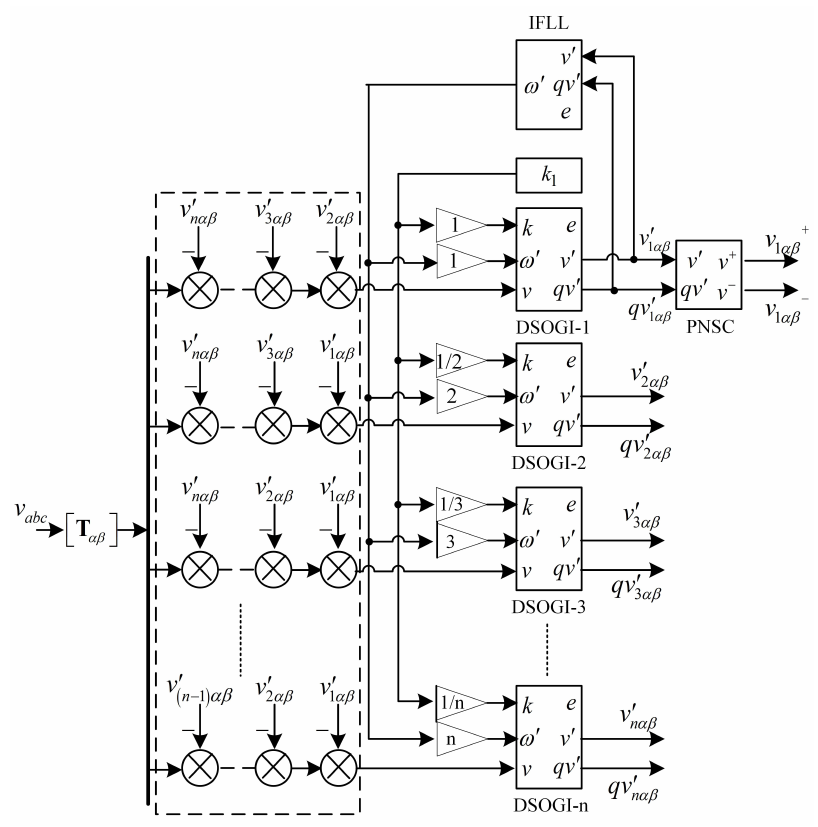
Figure 5. Structure of the